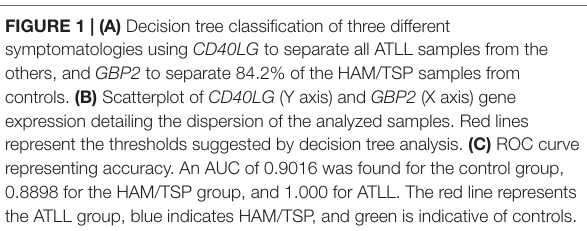
FIGURE 1 | (A) Decision tree classification of three different symptomatologies using CD40LG to separate all ATLL samples from the others, and GBP2 to separate 84.2% of the HAM/TSP samples from controls. (B) Scatterplot of CD40LG (Y axis) and GBP2 (X axis) gene expression detailing the dispersion of the analyzed samples. Red lines represent the thresholds suggested by decision tree analysis. (C) ROC curve representing accuracy. An AUC of 0.9016 was found for the control group, 0.8898 for the HAM/TSP group, and 1.000 for ATLL. The red line represents the ATLL group, blue indicates HAM/TSP, and green is indicative of